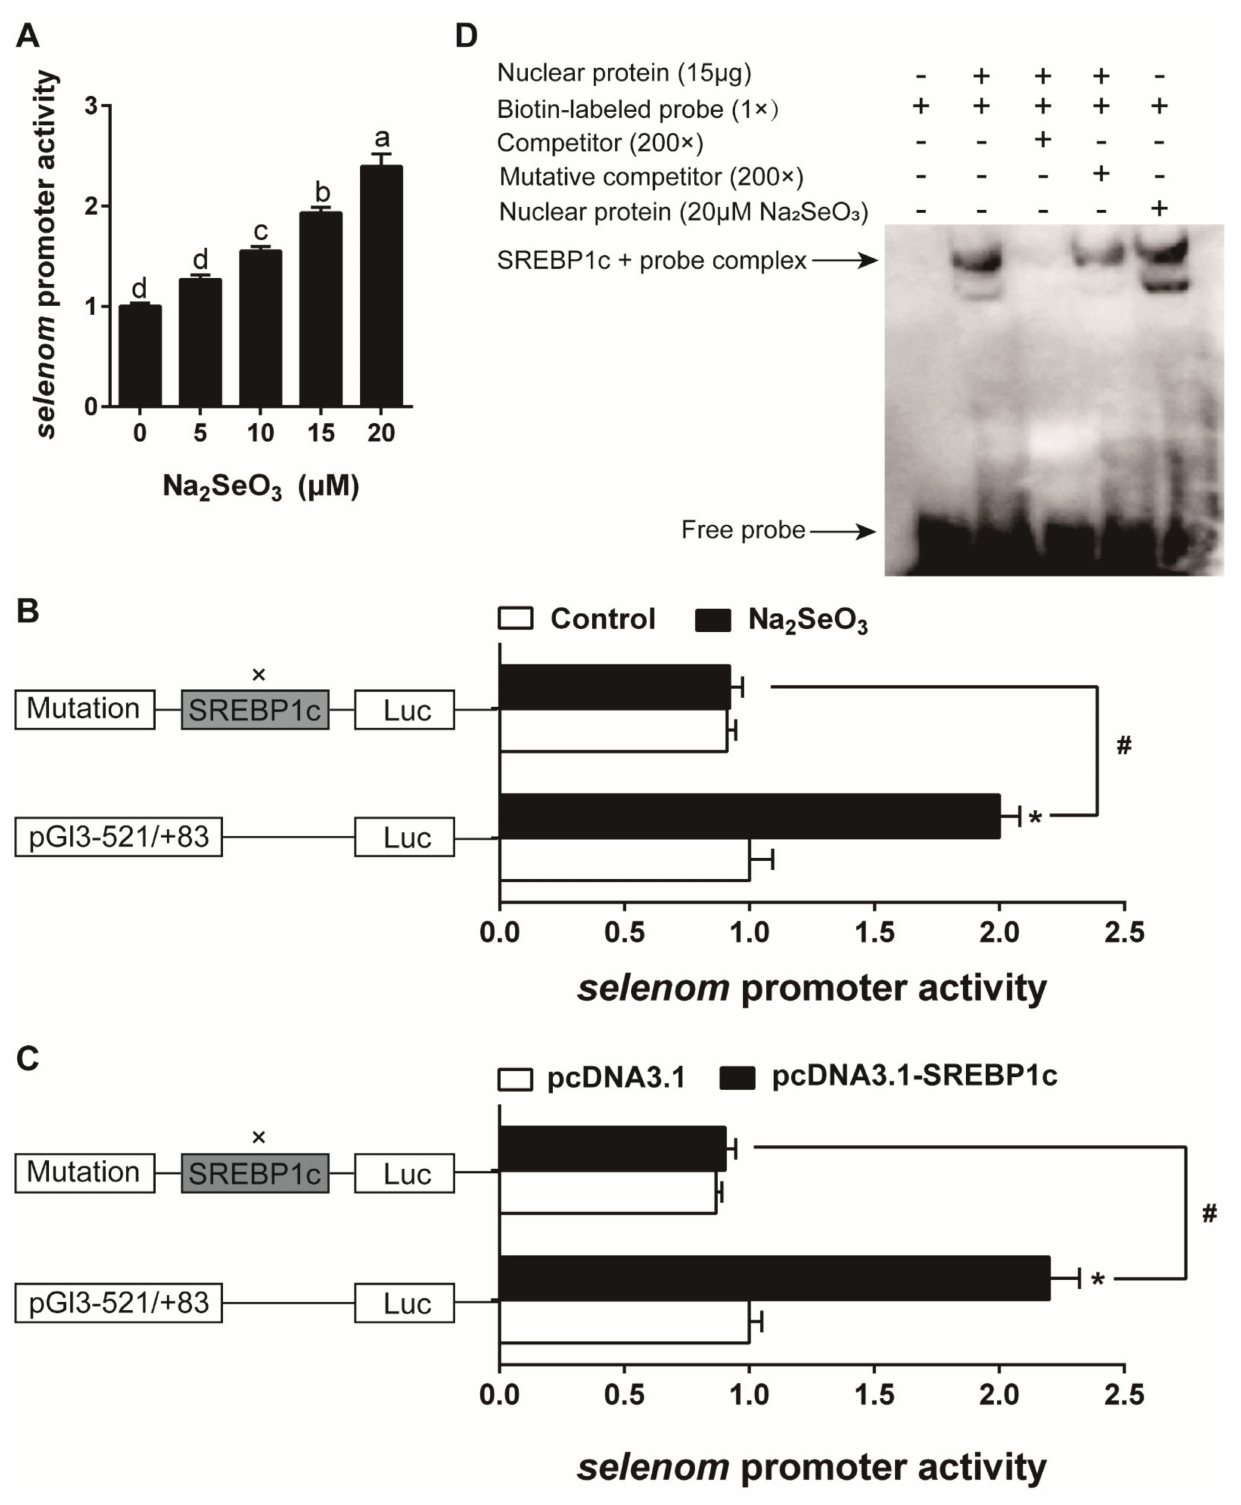
Figure 9. selenom promoter activity assays ( A – C ) and EMSA analysis ( D ) in the experiment 2. Values are means ± SEMs, n = 3. * Different from control, p < 0.05 (Student’s t test) and # Different from wild plasmid, p < 0.05 (Student’s t